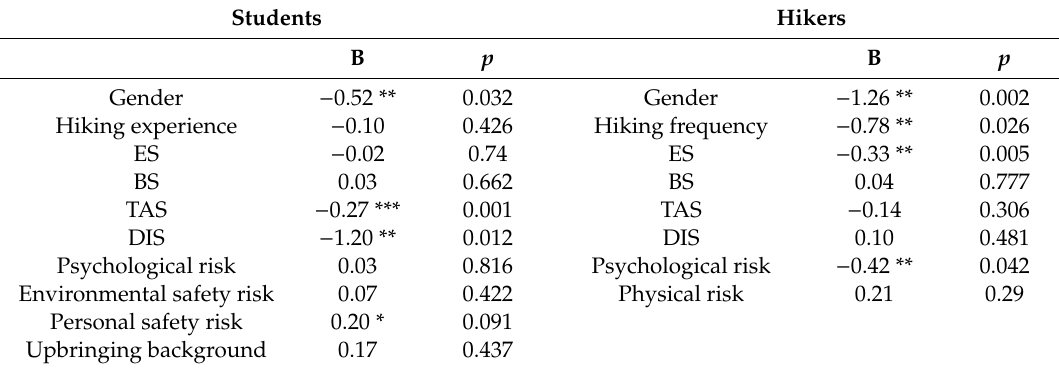
Table 5. Logistic regression on hiking